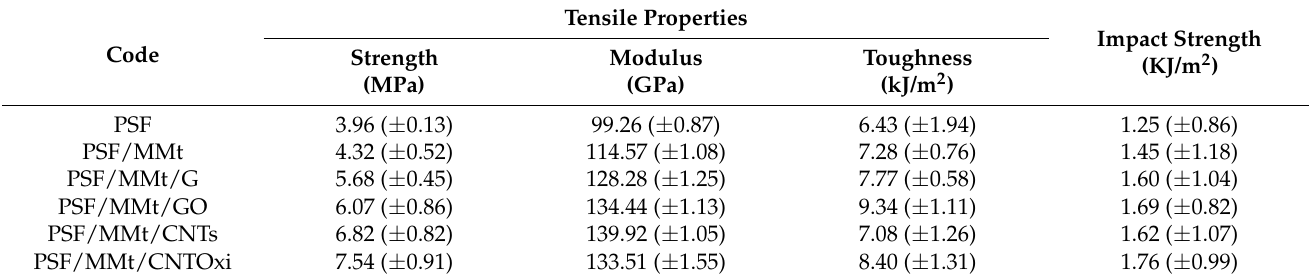
Table 4. Tensile properties and impact strength of PSF and its related carbon-based nanocomposites.